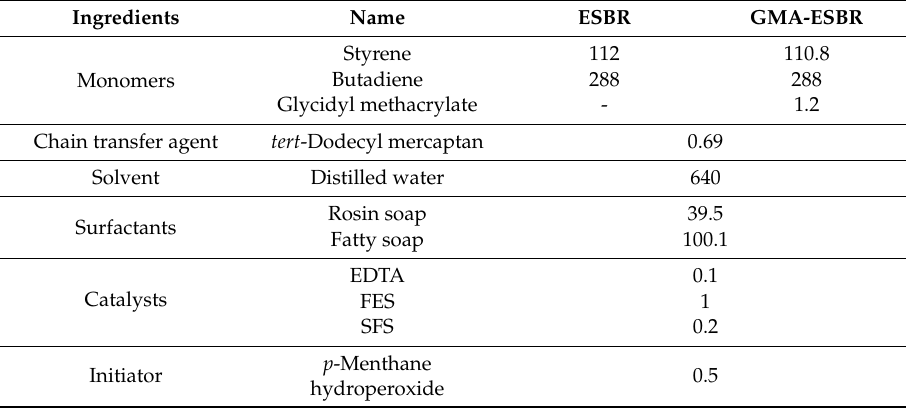
Table 1. Formulation for the ESBR and GMA-ESBR polymerization